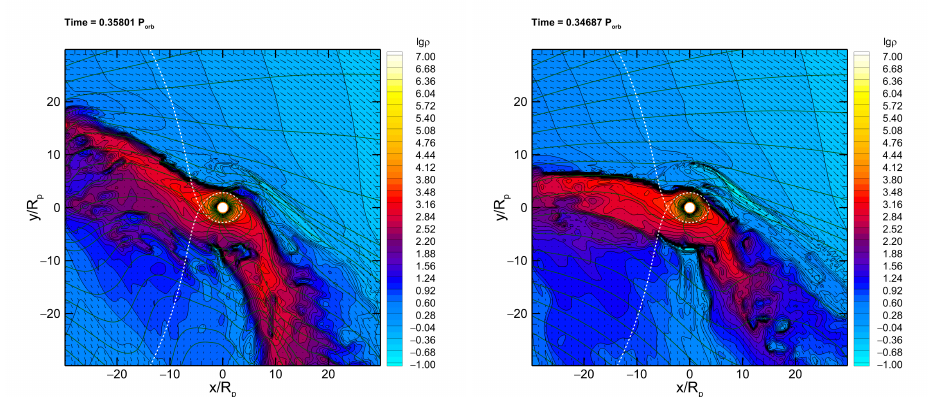
Figure 10. Distributions of density (color, iso-lines), velocity (arrows), and magnetic field (lines) in the orbital plane at a time moment approximately equal to one third of the orbital period for Model 5 ( B s = 0.2 G, left ) and Model 6 ( B s = 0.5 G, right ). The density is expressed in units of ρ w . The dotted line shows the border of the Roche lobe. The white circle corresponds to the photometric radius of the